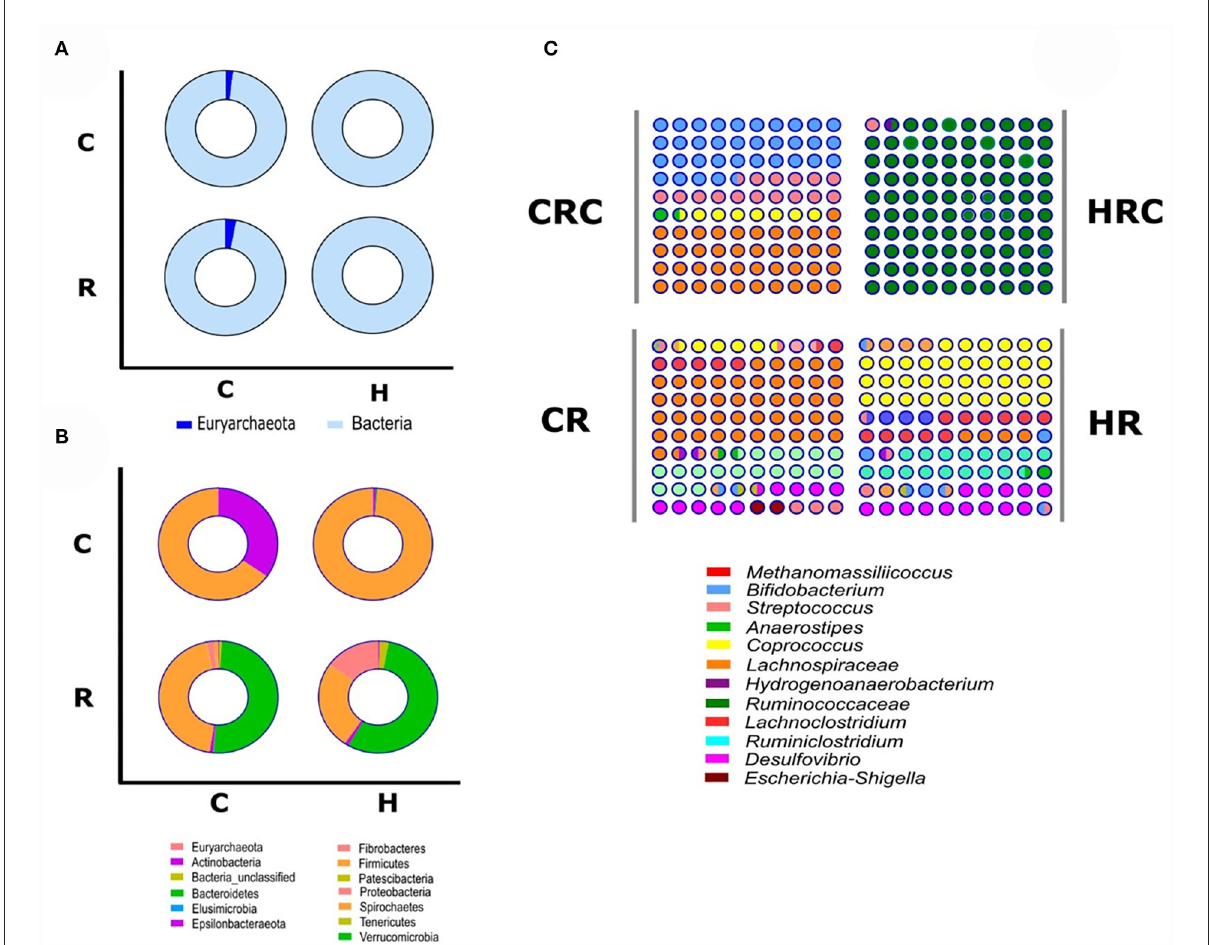
FIGURE5 Microbial diversity in feces and culture samples. Microbiota derived from feces of control rats (CR), rats with hepatoma (HR), and direct from rats (R) and cultures (C). Microorganisms were analyzed by Domain (A) Euryarchaeota (dark blue) and Bacteria (cyan), by phylum (B) , and by genus (C) . Only microorganisms with a relative abundance > 0.05 % were considered and evaluated by 16S rRNA